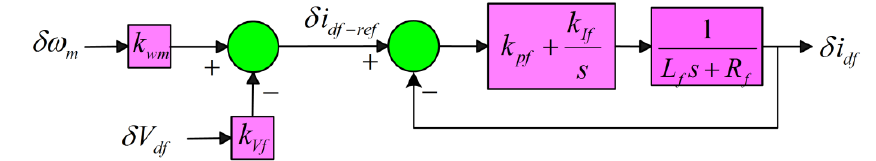
Figure 9. Small-signal block diagram of the grid-side controller.